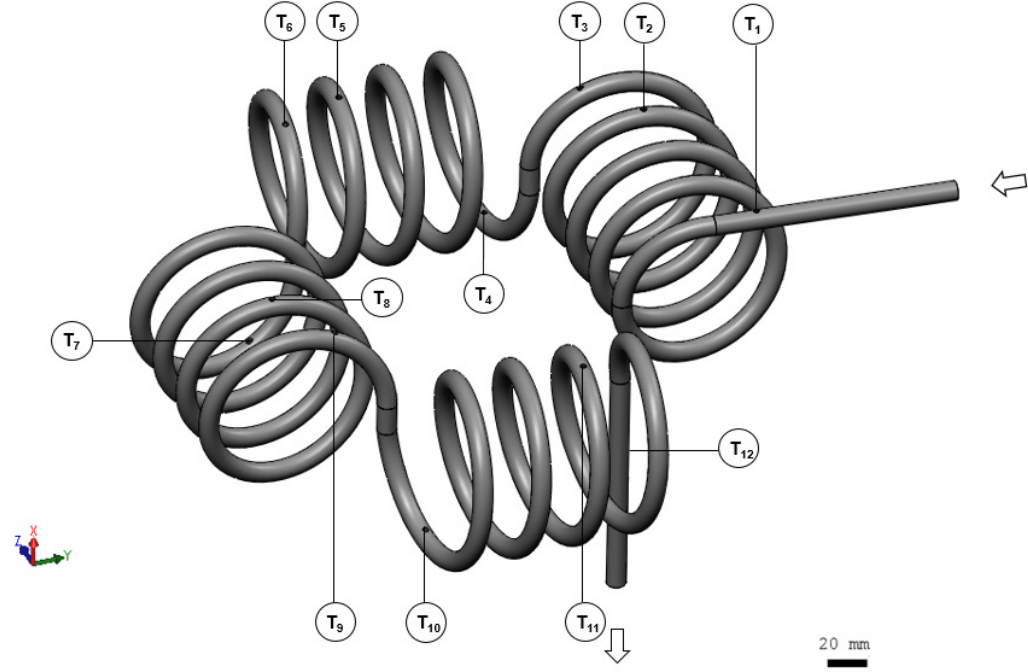
Figure 1. ( a ) Schematic of the experimental test rig. ( b ) Photograph of the experimental setup.